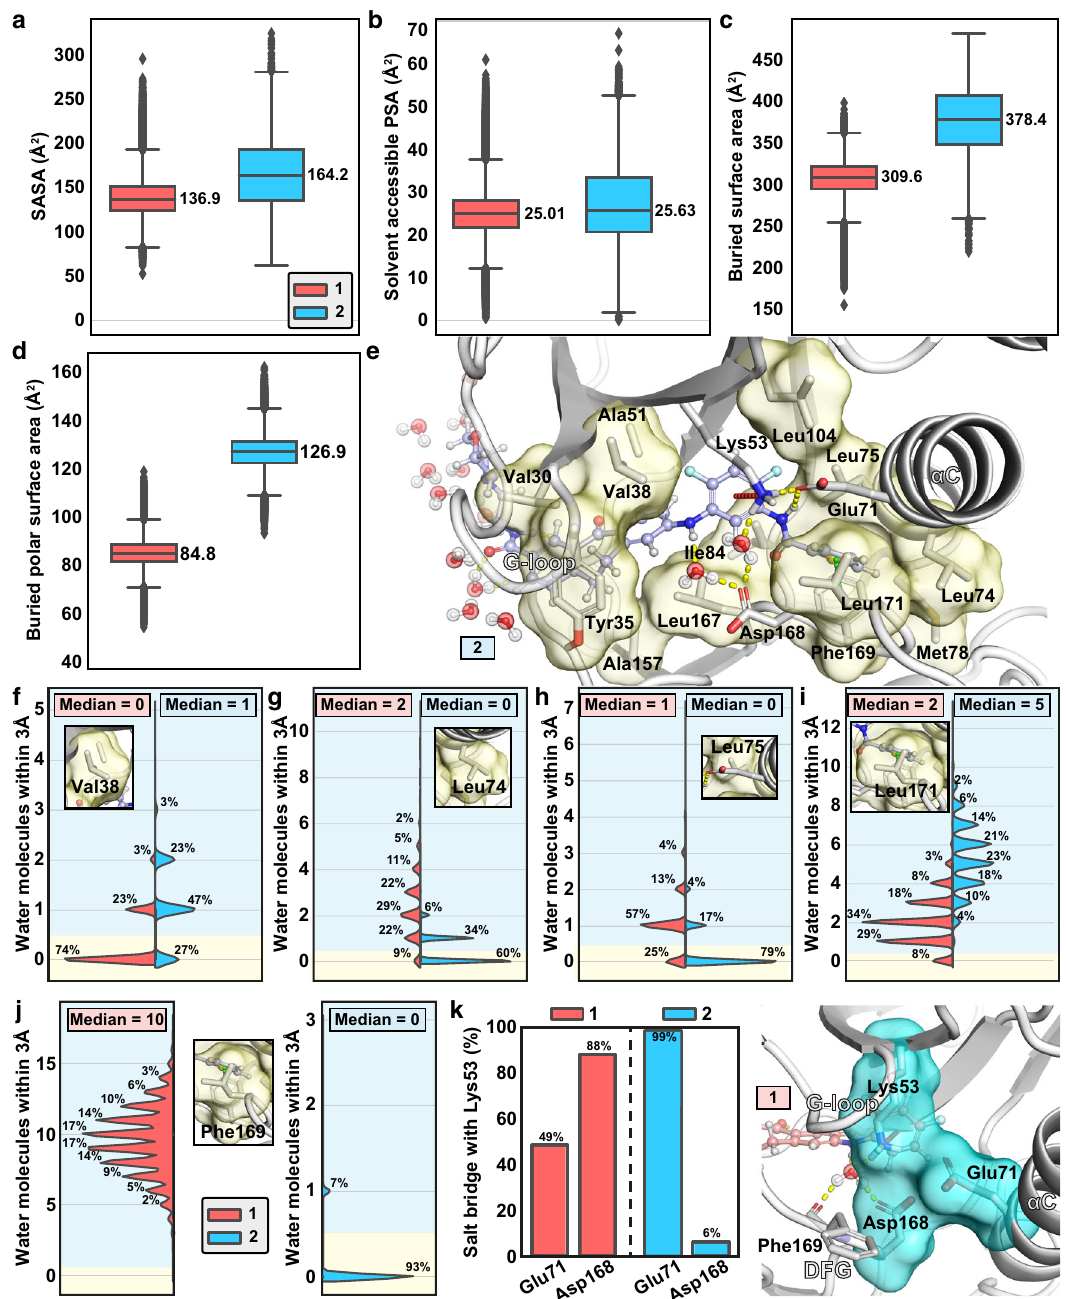
Fig. 4 Solvent exposure of the inhibitors and the binding site residues. a Solvent accessible surface area (SASA) of 1 and 2 . b Solvent accessible polar surface area of 1 and 2 . c Buried surface area (non-solvent exposed) of 1 and 2 . d Buried polar surface area of 1 and 2 . The black horizontal line in the box represents the median. Box displays the quartiles of the dataset (25 – 75%) and whiskers the rest of the data with maximum 1.5 IQR. Outliers are indicated with black diamonds. e Hydrophobic residues in the binding site that were monitored for their side chain solvent exposure are shown in stick model with their molecular surfaces illustrated in yellow. Compound 2 is shown in ball and stick model. Solvent exposure of Val38 ( f ), Leu74 ( g ), Leu75 ( h ), Leu171 ( i ), and Phe169 ( j ). f – j The blue background indicates solvent exposure (where ≥ 1 water molecule is located within 3 Å of the side chain) and the yellow background indicates when the side chain is not exposed to solvent. Solvent exposure of Val30, Tyr35, Ala51, Met78, Ile84, Leu104, Ala157, and Leu167 is shown in Supplementary Fig. 9. k Intra-protein salt bridge frequencies to catalytic Lys53. Simulation data was analysed for each 1 ns i.e., data in a – k consist of 91,328 and 86,505 individual data points for 1 and 2 , respectively. Source data are provided as a Source Data fi